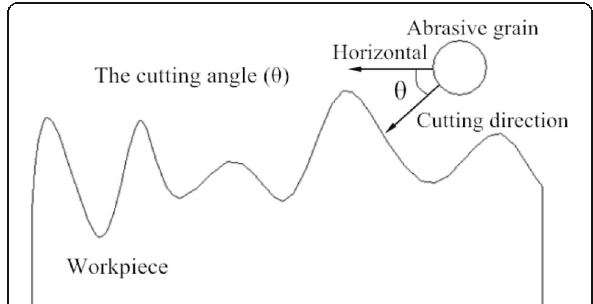
Fig. 5 The sketch of cutting angle. Figure 5 is the sketch of the different cutting angles when the abrasive grains are cut. Abrasive grain from different directions cutting the workpiece material, the material will have the performance and processing quality will be